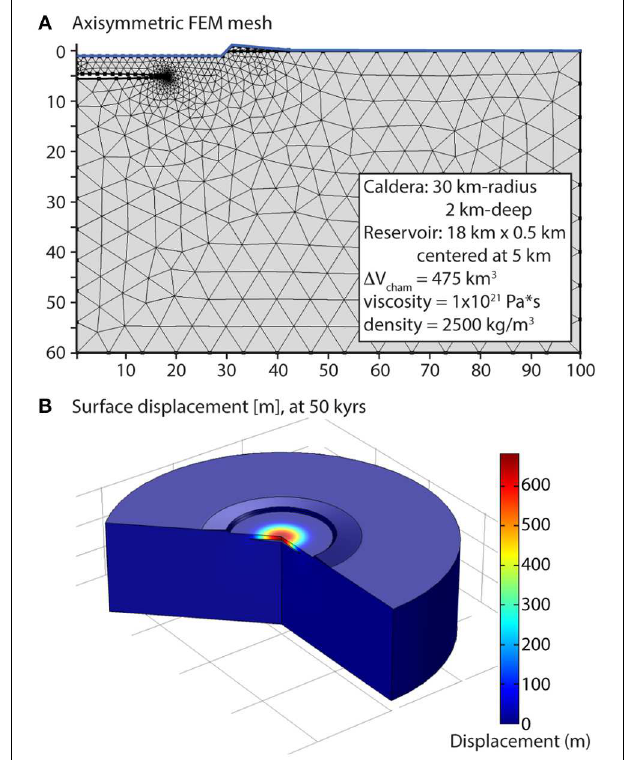
FIGURE 8 | Model mesh (A) and displacement (B) for 475km 3 of magmatic recharge into a host rock with a constant viscosity rheology, η r = 1 × 10 21 Pa s. Maximum surface uplift is ∼